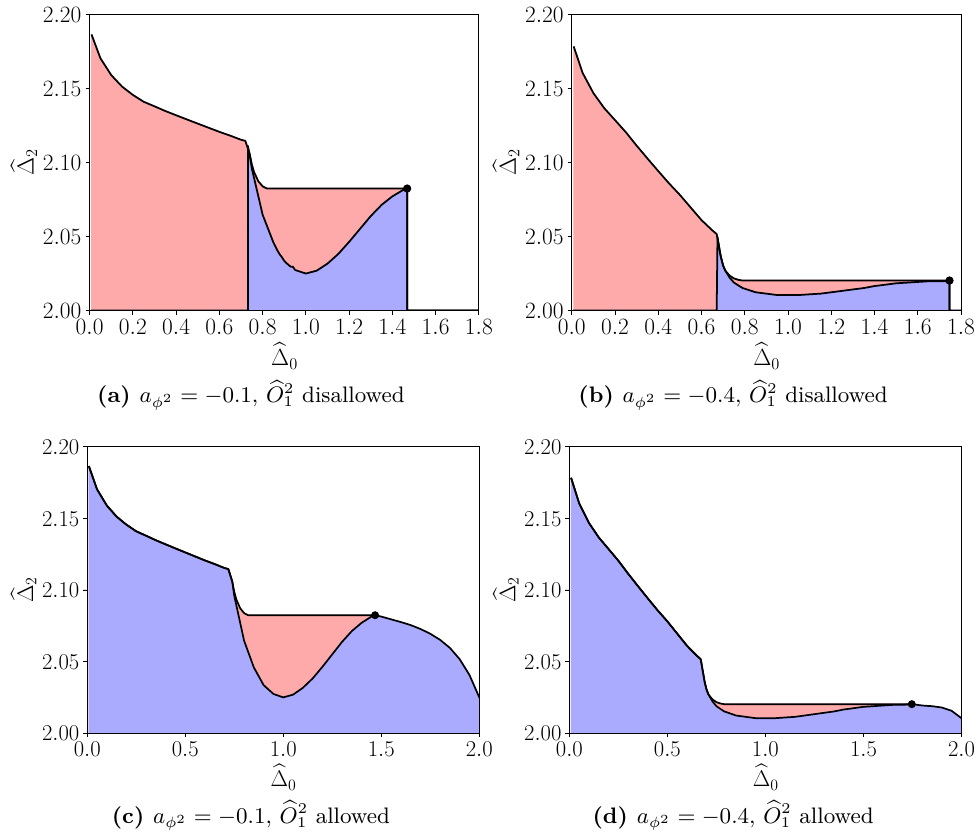
. In the blue region, b ∆ is Figure 5. Allowed points in ( b ∆ 0 , b ∆ 2 ) space for selected values of a 0 φ 2 the dimension of the unique relevant scalar while b ∆ is the spin 2 gap. In the pink region, they 2 are both gaps. The rightmost corner (indicated with a dot) is where we conjecture that a minimal boundary condition lives. For previous examples of corners which maximize two gaps, see [28–32]. It would be interesting to find an interpretation of the second kink to the upper left. Note that the smallest blue region is obtained when all possibilities for a second relevant scalar, including the one that can only appear in b O , are disallowed. If one only disallows a generic second relevant 1 × b O 1 scalar, the blue and pink regions become more